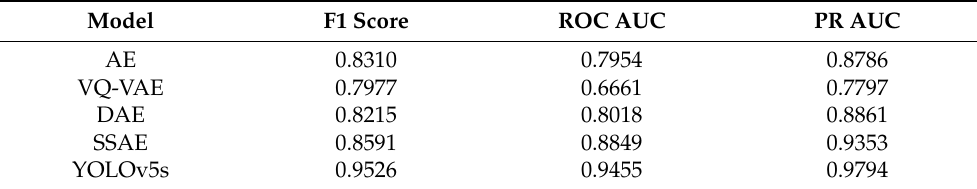
Table 4. Comparison of three autoencoder models AE, DAE and VQ-VAE and baseline YOLOv5s